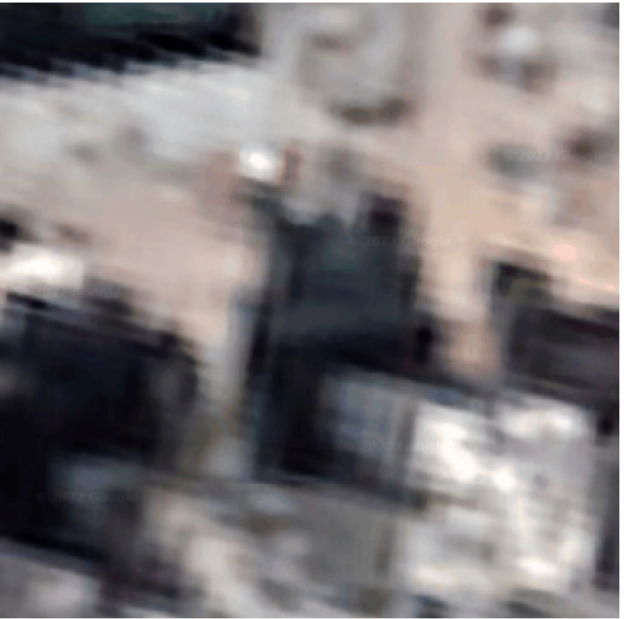
Fig 4. An example of a blurry aerial image. Sometimes this is deliberate by the satellite imagery provider for privacy reasons.